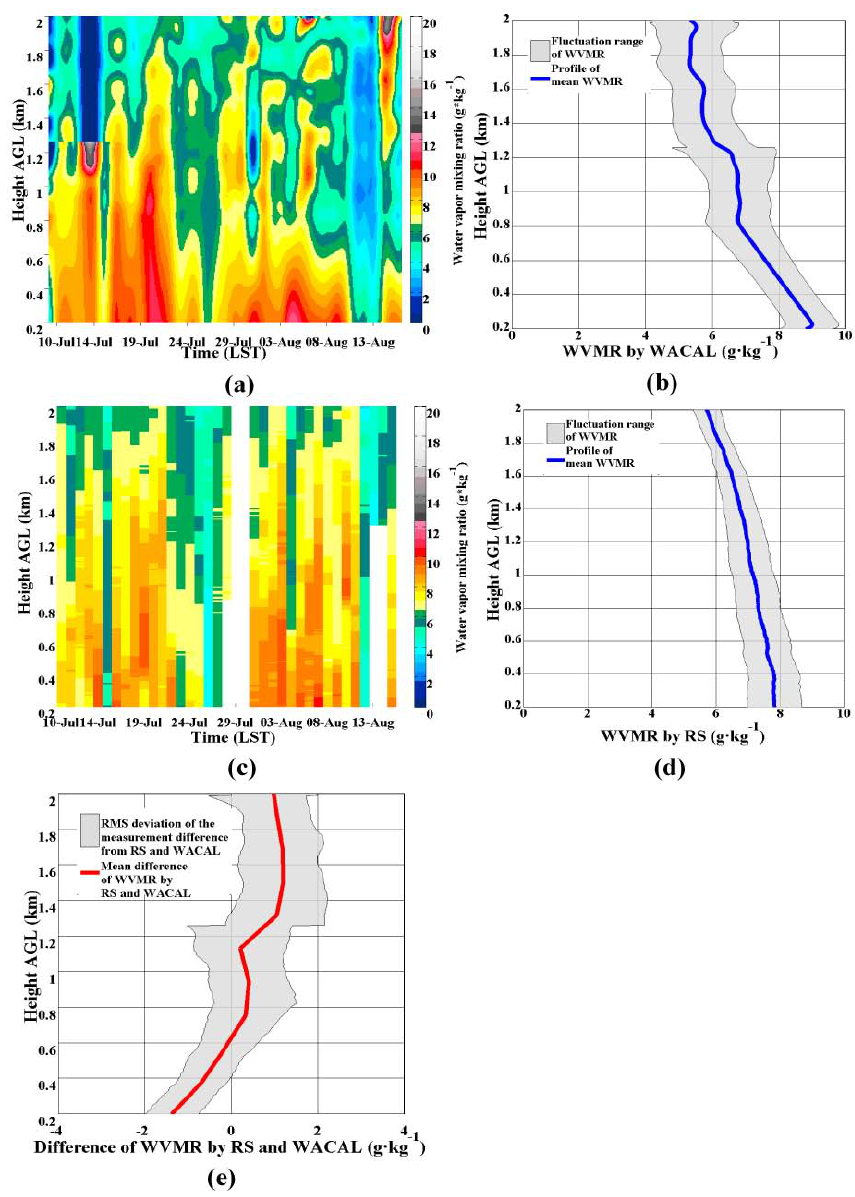
Figure 5. (a) Time serials of water vapor mixing ratio at 21:30LST from 10 July to 16 August measured by WACAL; (b) profile of mean water vapor mixing ratio and fluctuation range of water vapor mixing ratio from 10 July to 16 August measured by WACAL; (c) time serials of water vapor mixing ratio at 21:30LST from 10 July to 16 August measured by radiosonde (RS); (d) profile of mean water vapor mixing ratio and fluctuation range from 10 July to 16 August measured by RS and (e) mean difference of water vapor mixing ratio measured by WACAL and RS and the corresponding root mean square